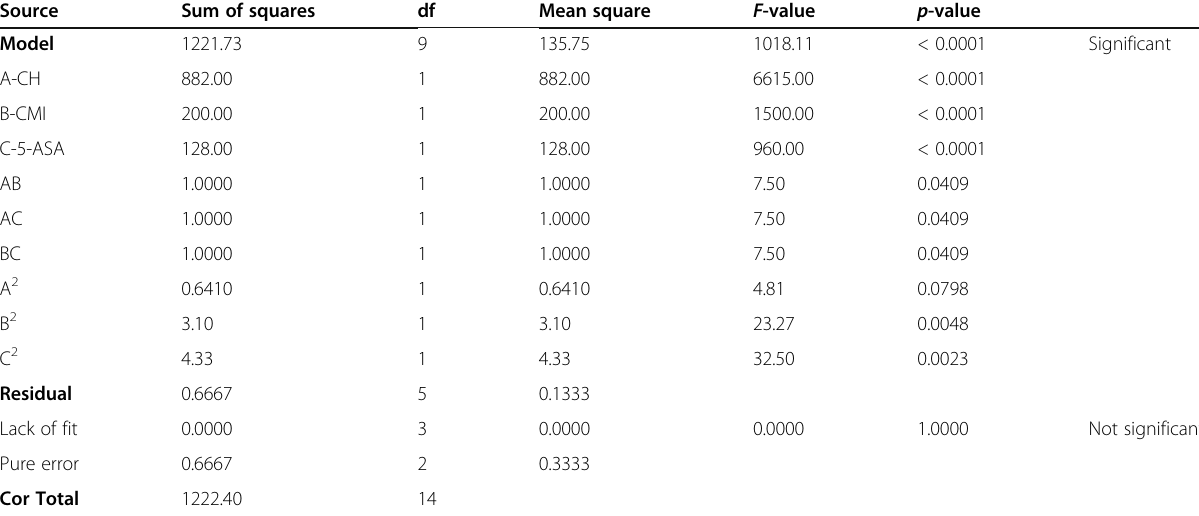
Table 5 Statistical analysis result of entrapment efficiency